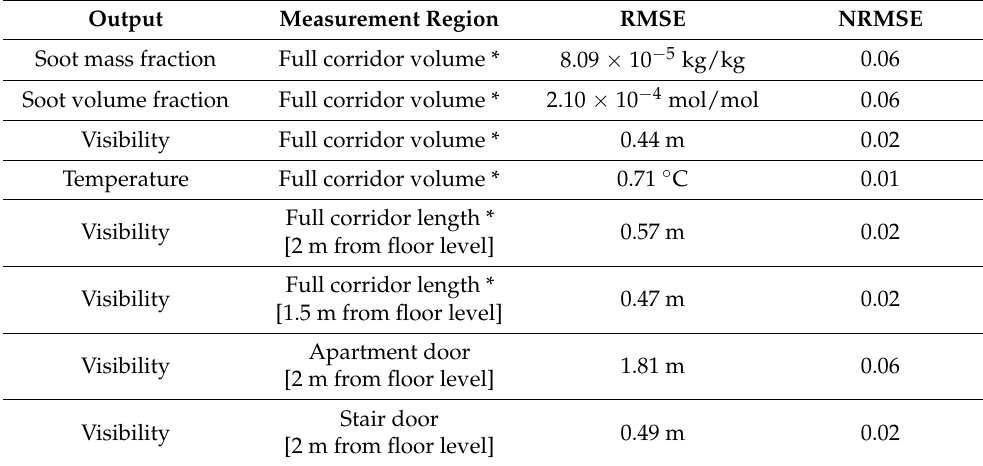
Table 9. RMSE and NRMSE between the established and compressed timeline outputs for the means of escape